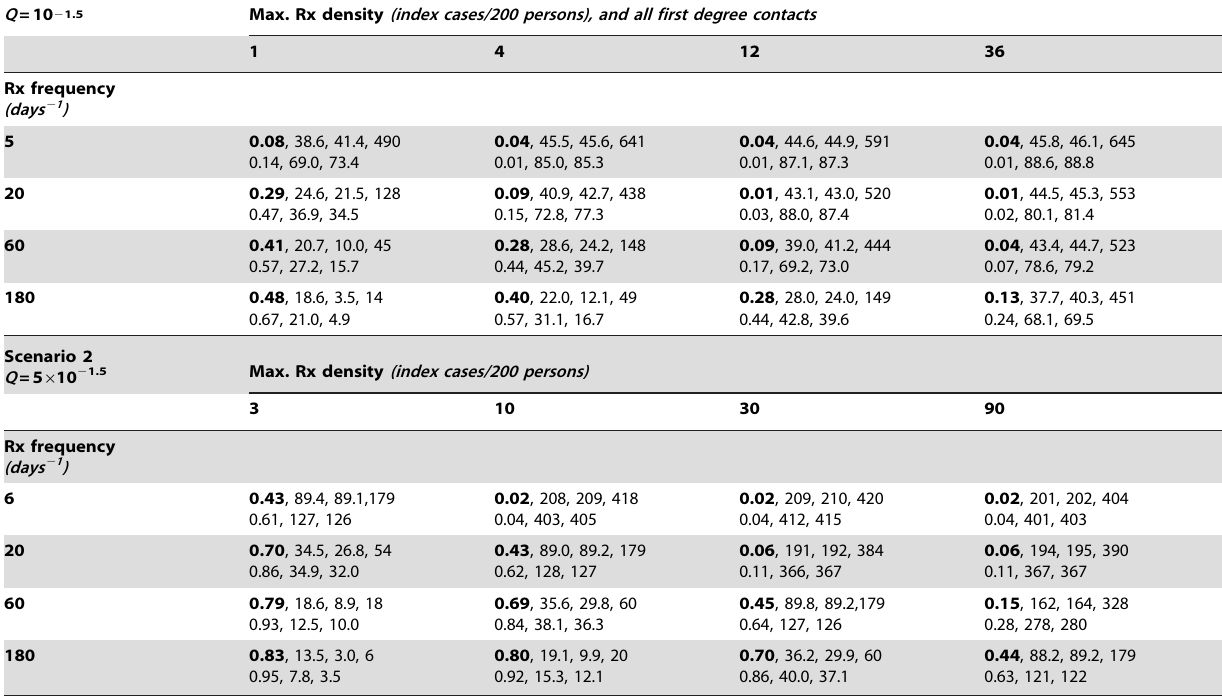
Table 3. Effects of different treatment protocols on scabies burden. Scenario 1 Q =10 2 1.5